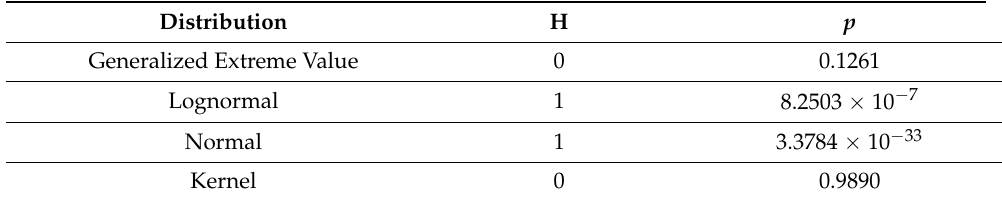
Table 6. Results of K–S test for case